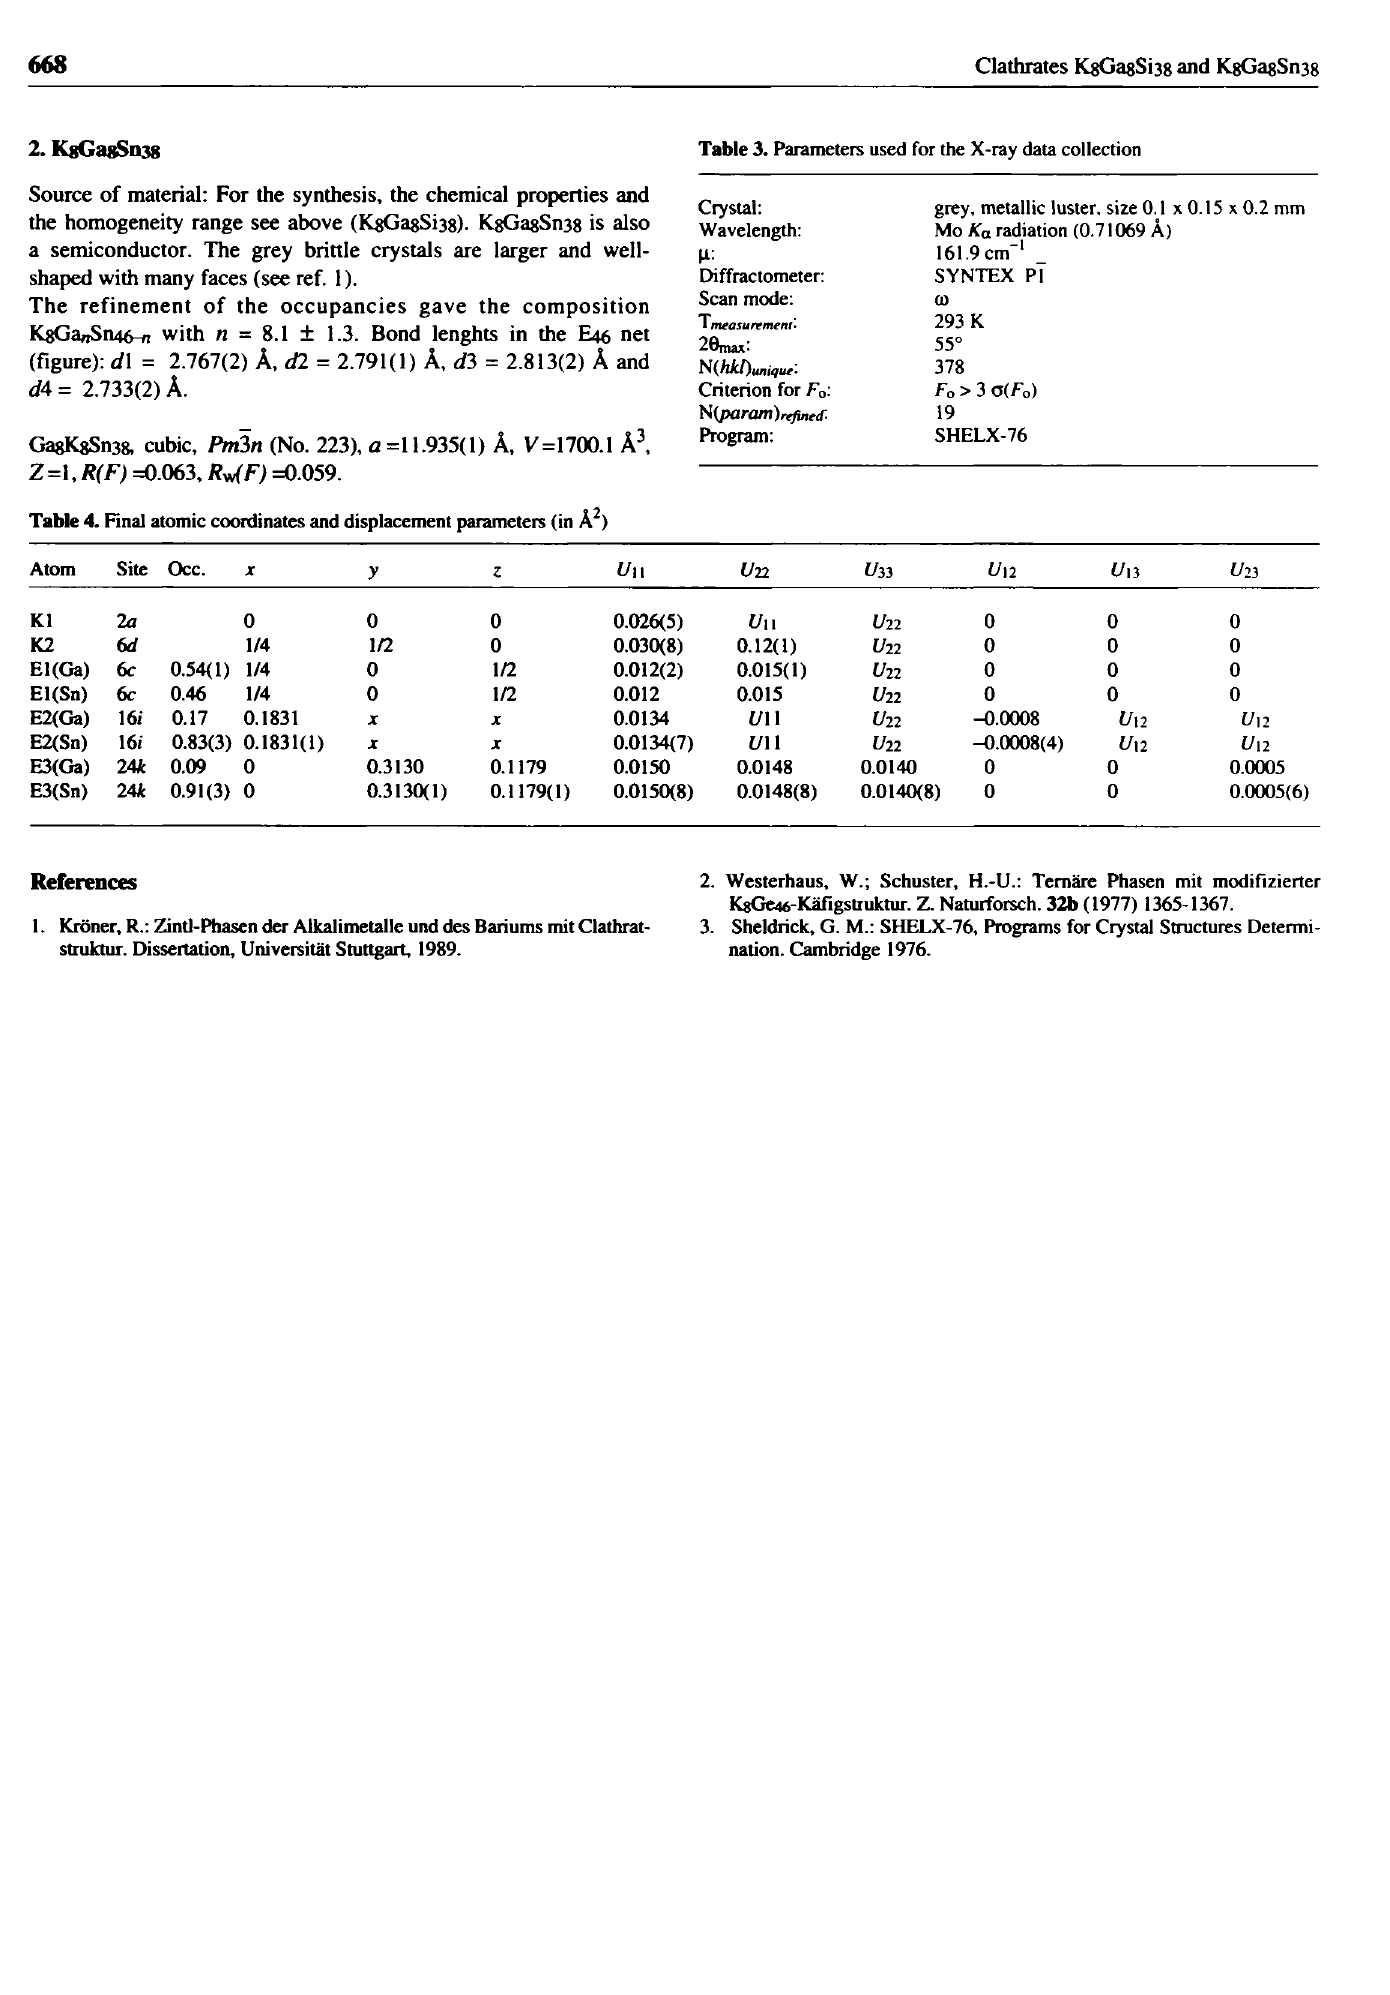
Table 3. Parameters used for the X-ray data collection